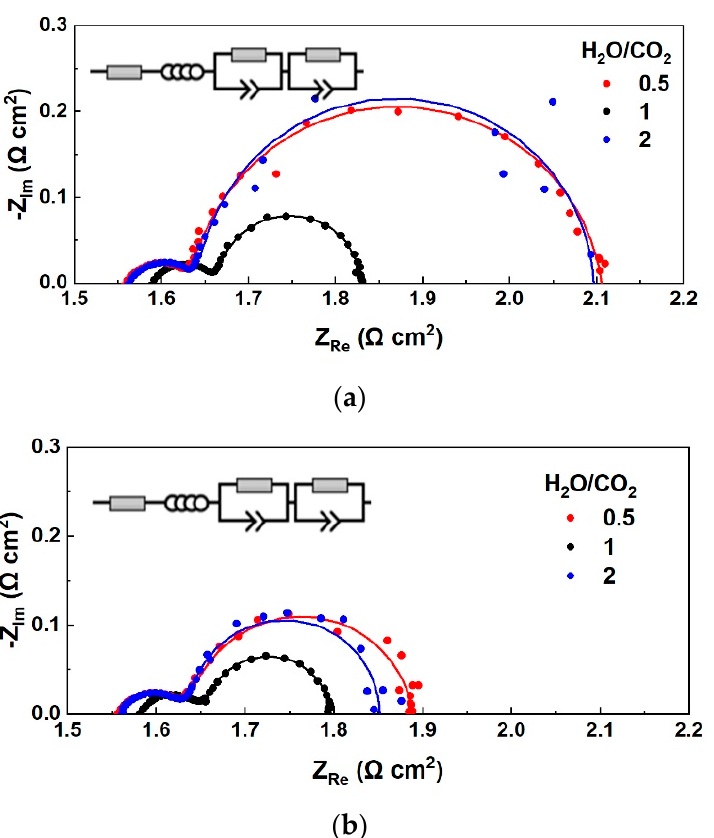
Figure 2. The electrochemical performance of the button cell under co-electrolysis. Nyquist plots recorded at ( a ) 0 mA cm − 2 (open circuit) and ( b ) 250 mA cm − 2 for different H 2 O/CO 2 ratios in the fuel electrode feed with H 2 co-feed, balanced with He, for a frequency range of 100 kHz − 10 mHz and an amplitude of 20 mA.